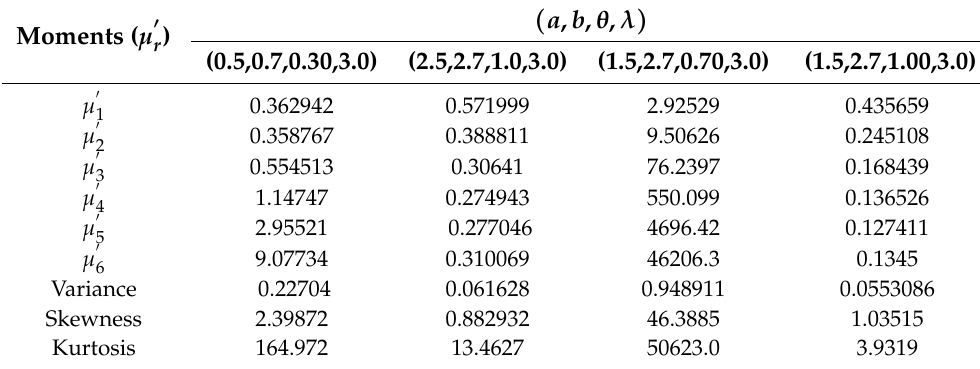
Table 2. Some numerical results for moments of the BBE 2